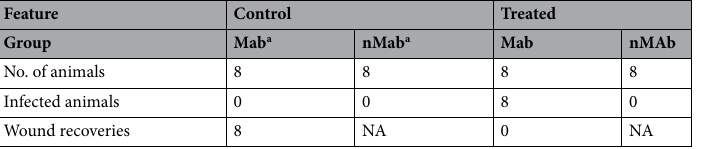
Table 1. Summary of the outcome of an in vivo bacterial challenge experiment with green sea urchins ( S. droebachiensis ) and V. echinoideorum . a = Mab, mechanical abrasion; nMab, none mechanical abrasion; NA, not